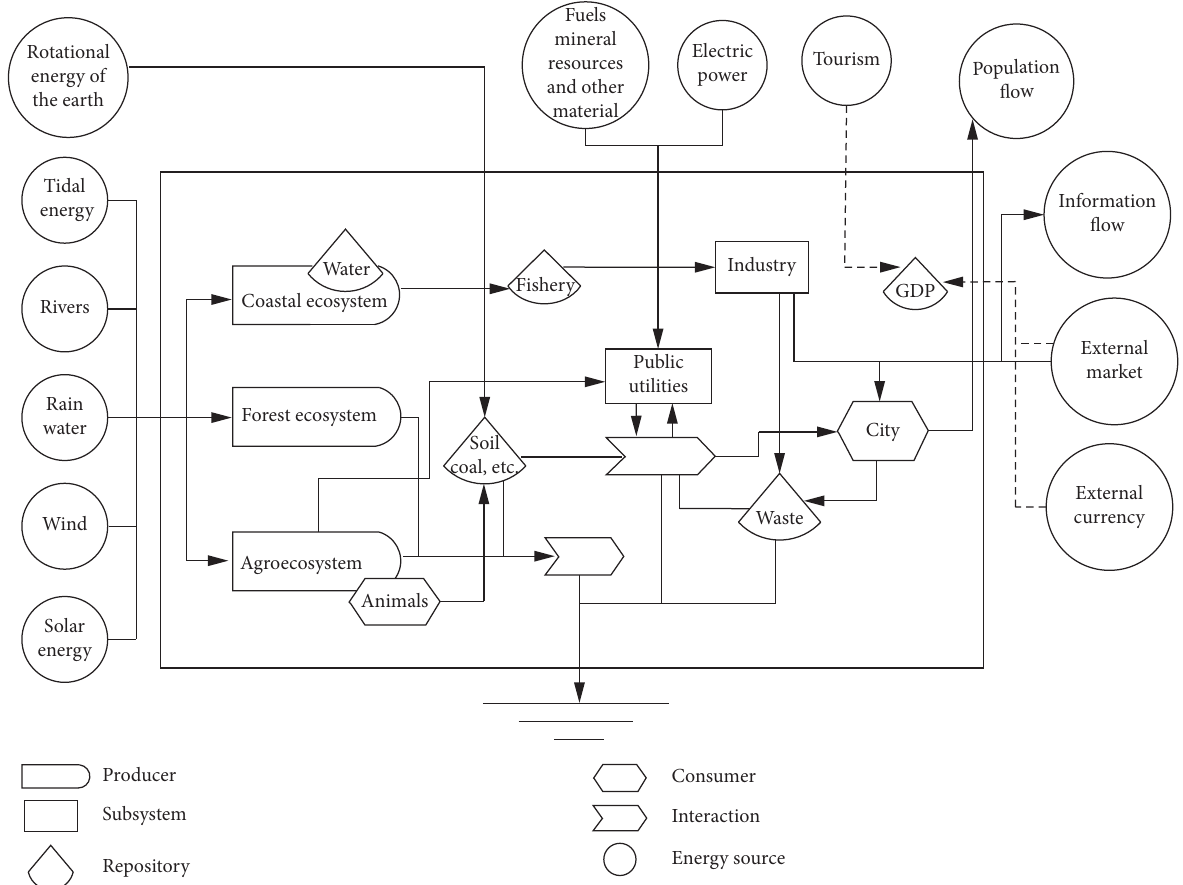
Figure 1: Energy flow diagram of coastal eco-economic system. Table 1: Calculation of emergy indicators of each city